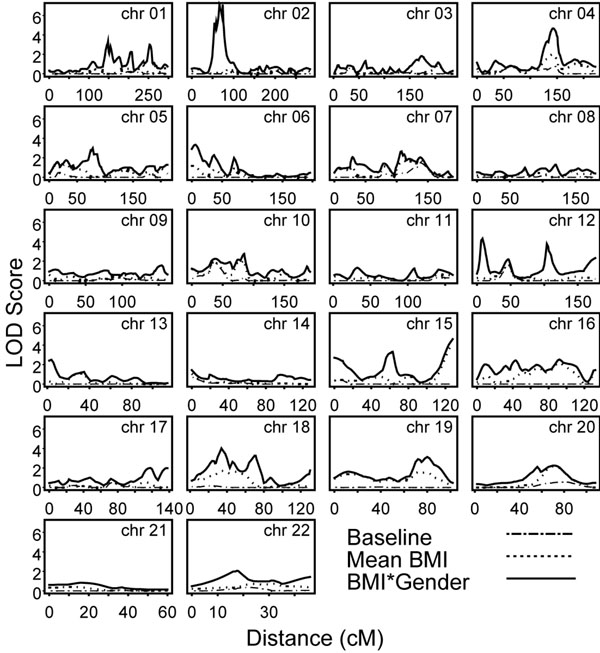
Genome scan plot Genome scan results for hypertension including the baseline (no covariates), the mean BMI only, and the full (mean BMI, gender, and BMI*gender interaction) models. Suggestive evidence of linkage (p < 0.001) corresponds to a LOD score of 2.8 or 3.8 for the single covariate and full models respectively, and significant evidence of linkage (p < 0.00001) corresponds to a LOD score 4.8 and 6.0, respectively.